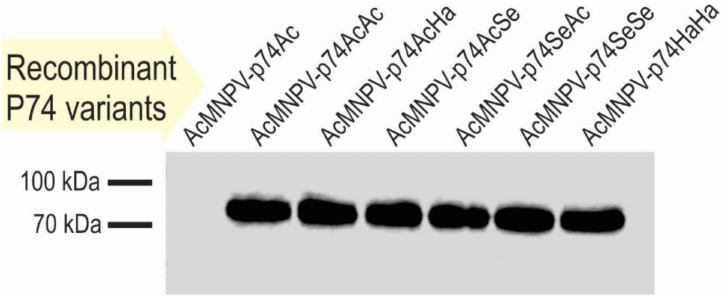
Figure 5. Recombinant P74 protein detection in OBs. Immunodetection of P74 variants in OBs by Western blot using antibodies anti-6 × His-tag. The source of the OBs evaluated is indicated on each lane.